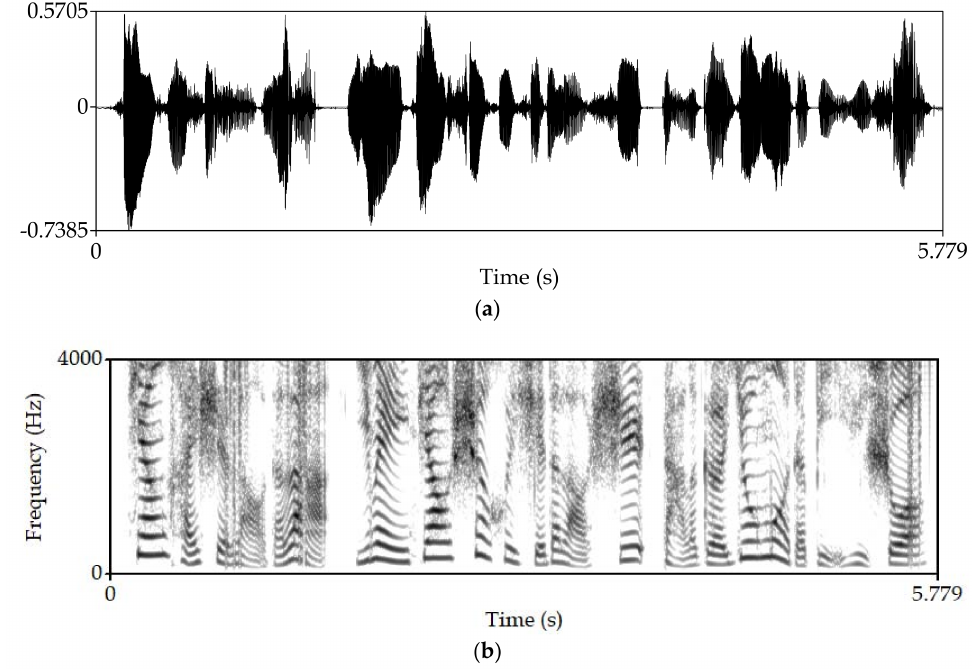
Figure 11. Recovered speech signal, different parts of the signal are tampered separately ( a ) Waveform ( b )